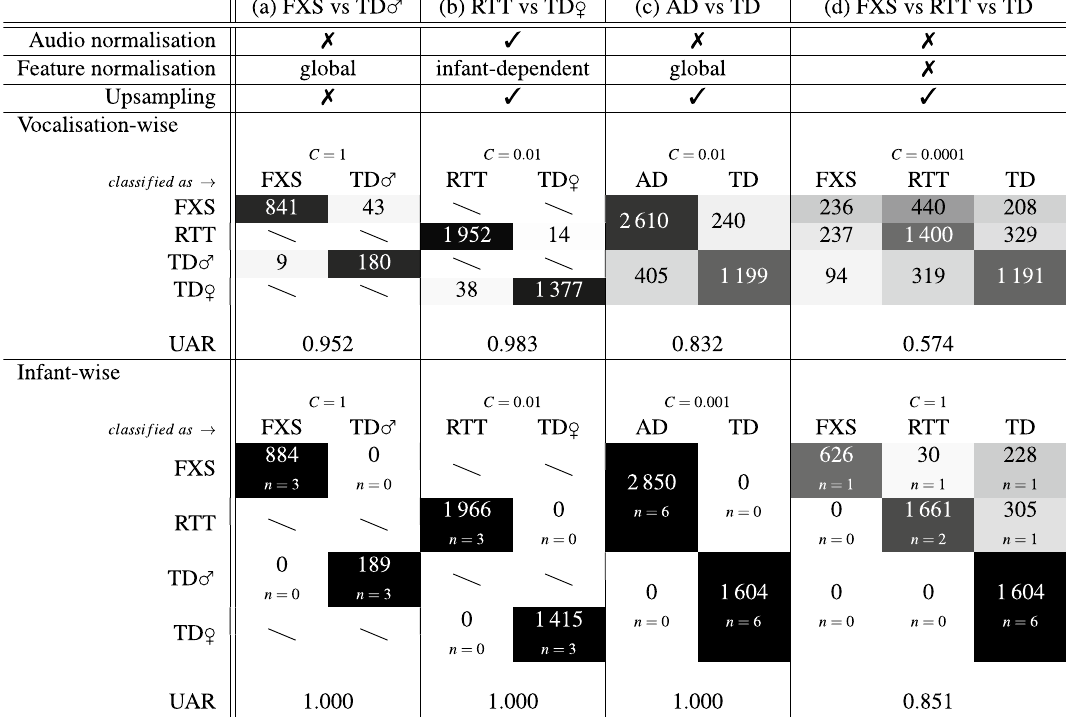
Table 2. Paradigm-wise (a)–(d) best system configuration regarding audio normalisation, feature normalisation, and training partition upsampling, as well as respective classification results in form of class- specific numbers of (in)correctly assigned vocalisations (confusion matrices) and unweighted average recall (UAR) for both vocalisation-wise and infant-wise evaluation scenario. UAR values are rounded to three decimal places. AD, atypical development; C, support vector machine kernel complexity parameter; FXS, fragile X syndrome; n, number of participants; RTT, Rett syndrome; TD, typical development; ♀ , female; ♂ , male; colour code for confusion matrices: greyscale proportional to the class-specific number of vocalisations between white = 0 % of class-specific vocalisations and black = 100 % of class-specific